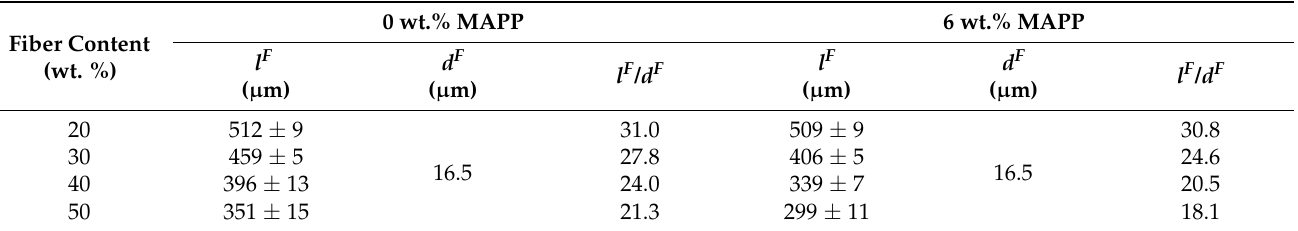
Table 3. Evolution of morphological parameters, mean fiber length ( l F ), mean fiber diameter ( d F ), and aspect ratio ( l F / d F ) with the fiber content. Fiber Content (wt.